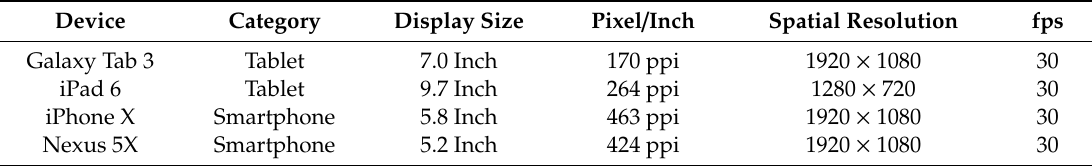
Table 2. Information of the devices used in